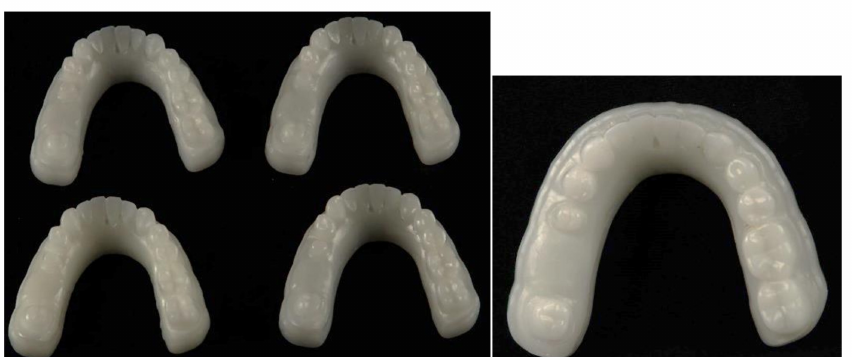
Figure 2. Milled working model.